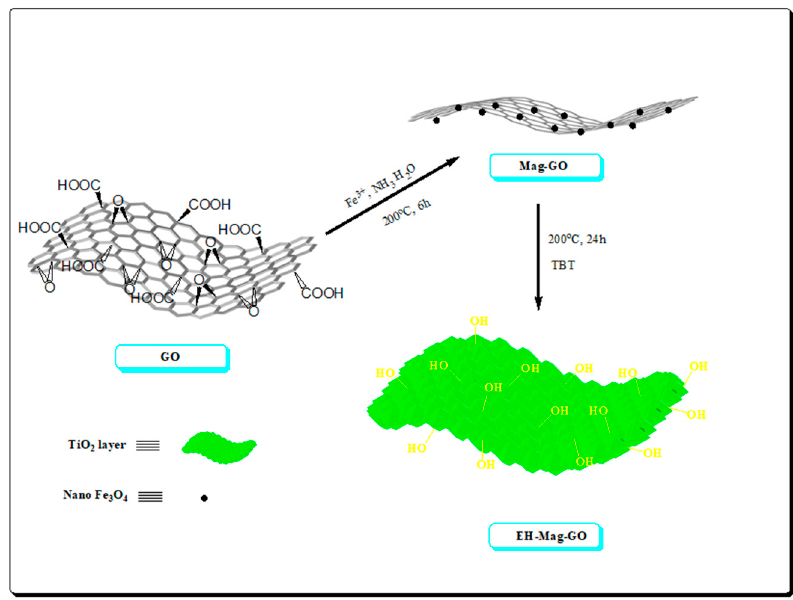
Figure 16. The preparation procedure of EH-Mag-GO. Reprinted with permission from Ref. [9]. Copyright (2018) Elsevier.